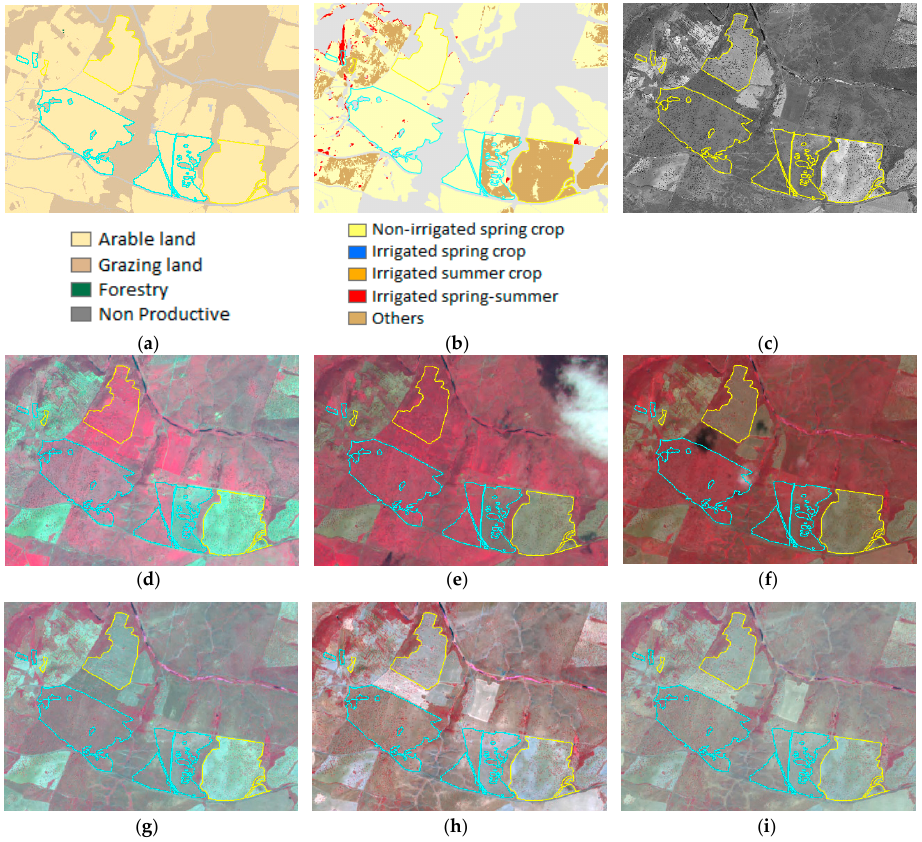
Figure 9. TS2 validation images. Cyan polygons are grassland areas that were classified as “non-irrigated spring herbaceous crops with low activity” or as “other crops”. Yellow polygons represent agricultural parcels. ( a ) LPIS data; ( b ) Arable land classification; ( c ) VHR image of spring 2016: Polygons in yellow to enhance visualization; ( d ) Sentinel-2 infrared composite. Date: 25 March 2016; ( e ) Sentinel-2 infrared composite Date: 14 April 2016; ( f ) Sentinel-2 infrared composite Date: 27 May 2016; ( g ) Sentinel-2 infrared composite Date: 13 June 2016; ( h ) Sentinel-2 infrared composite Date: 26 July 2016; ( i ) Sentinel-2 infrared composite Date: 12 August 2016.